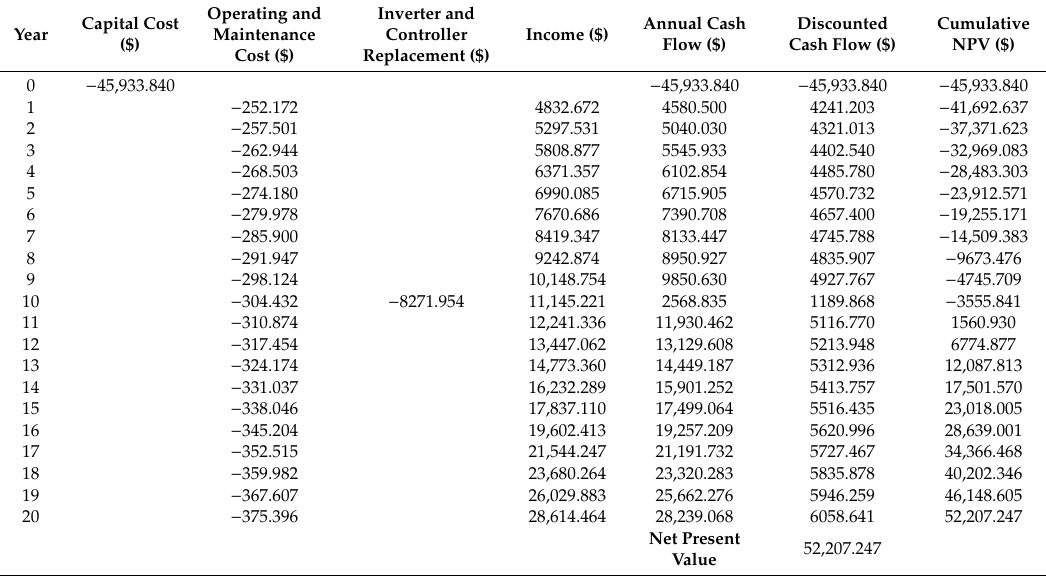
Figure 17. Cost-effectiveness analysis of the hybrid renewable energy harvester system in 20-year life cycle. Table 14. The financial analysis of the hybrid renewable energy harvester system (solar and wind energy system) in Subang city, Malaysia (20-year life cycle).